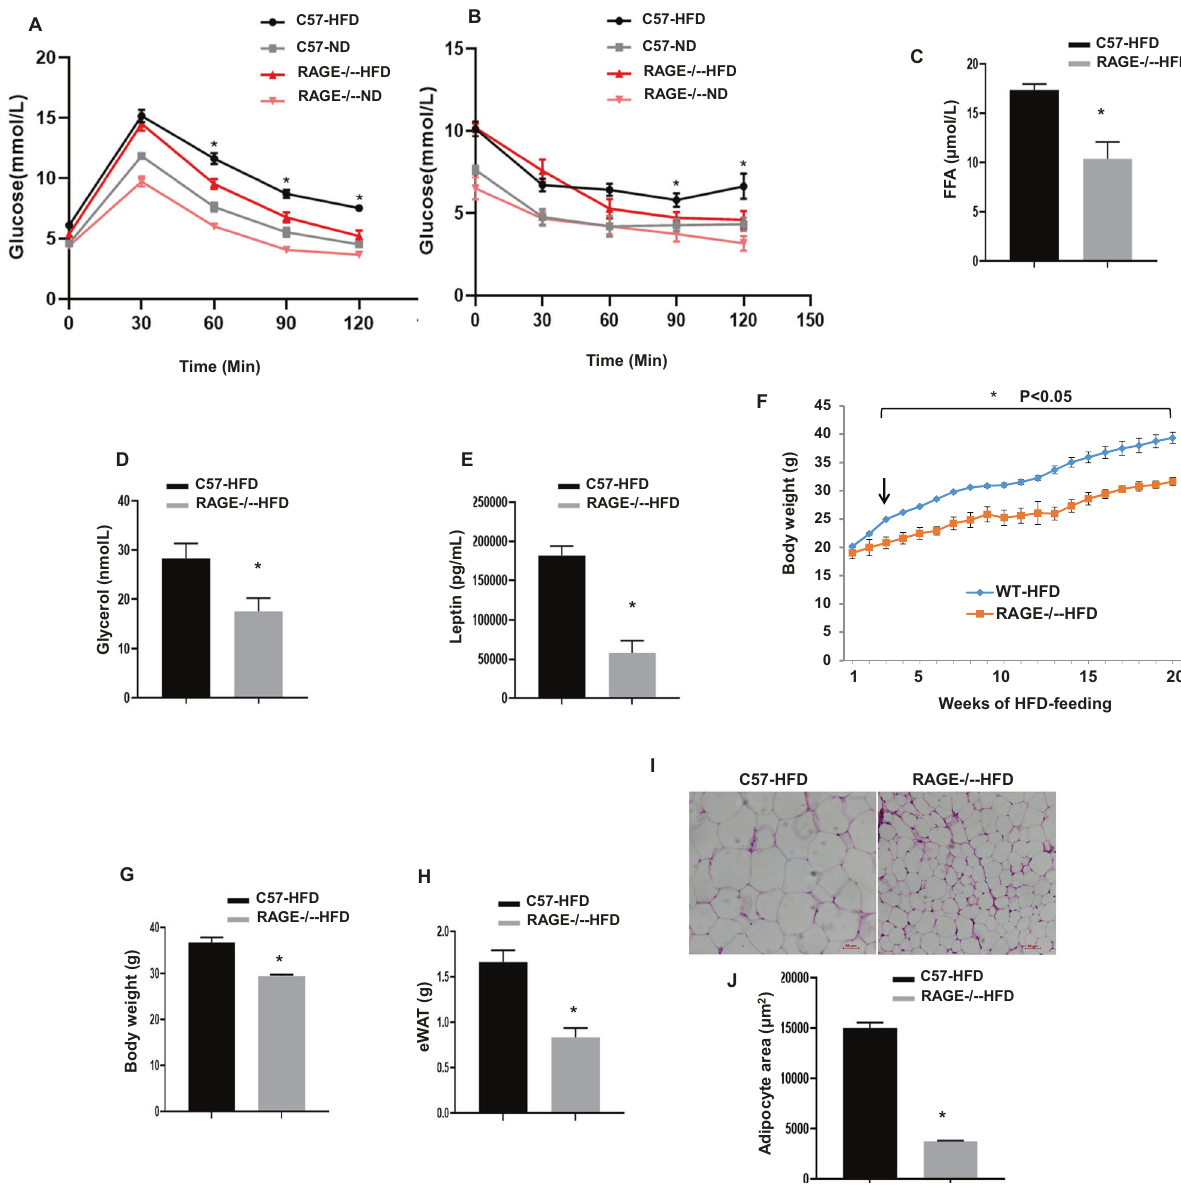
Fig. 1 RAGE de fi ciency improves glucose and insulin tolerance. Mice were fed HFD for 20 weeks. Glucose (GTT) ( A ) and Insulin (ITT) tolerance tests ( B ). n = 6 per group. * P < 0.05 vs. WT-ND and RAGE − / − -HFDmice. Plasma FFA ( C ), glycerol ( D ), and leptin ( E ) were measured by ELIS. n = 6 per group, * P < 0.05 Vs. WT-HFD mice. Temporal changes in body weight (measured weekly) are shown in panel F while panel G shows the bodyweight after 20 weeks of HFD feeding. n = 6 per group; *P < 0.05 Vs. WT-HFD mice. H eAT weight was measured ( n = 6 per group). *P < 0.05 Vs. WT-HFD mice. Data are mean ± SEM. I EAT sections were stained by hematoxylin. Representative histological images were obtained from WT-HFD and RAGE − / − -HFD mice. Scale bars: 50 μ m. J The area of adipocyte size is presented as graphs. n = 6 per group; *P < 0.05 Vs. WT-HFD mice. All group data are shown as mean ± SEM. FFA, free fatty acid; eAT, epididymal adipose